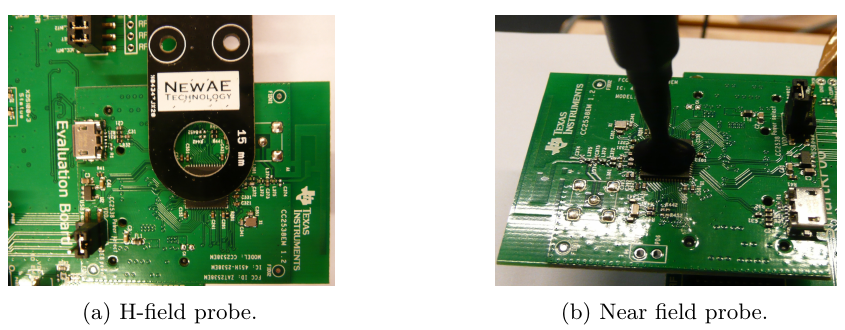
Figure 4: The EM probes used for measurement of the EM leakage.